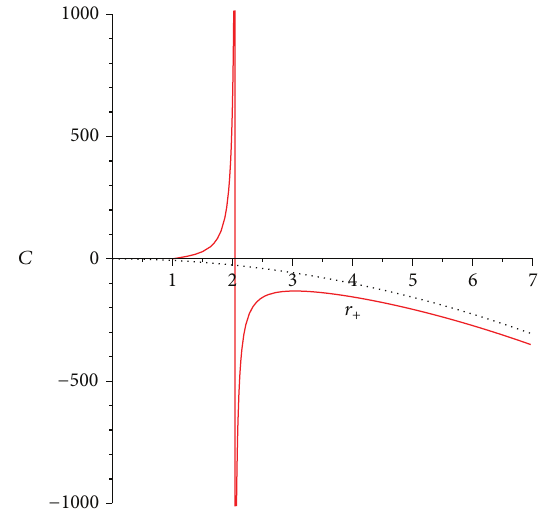
Figure 4: The solid curve represents the black hole heat capacity 𝐶 as a function of the horizon radius 𝑟 + in Planck units. The dotted curve represents the corresponding classical results in terms of the Schwarzschild